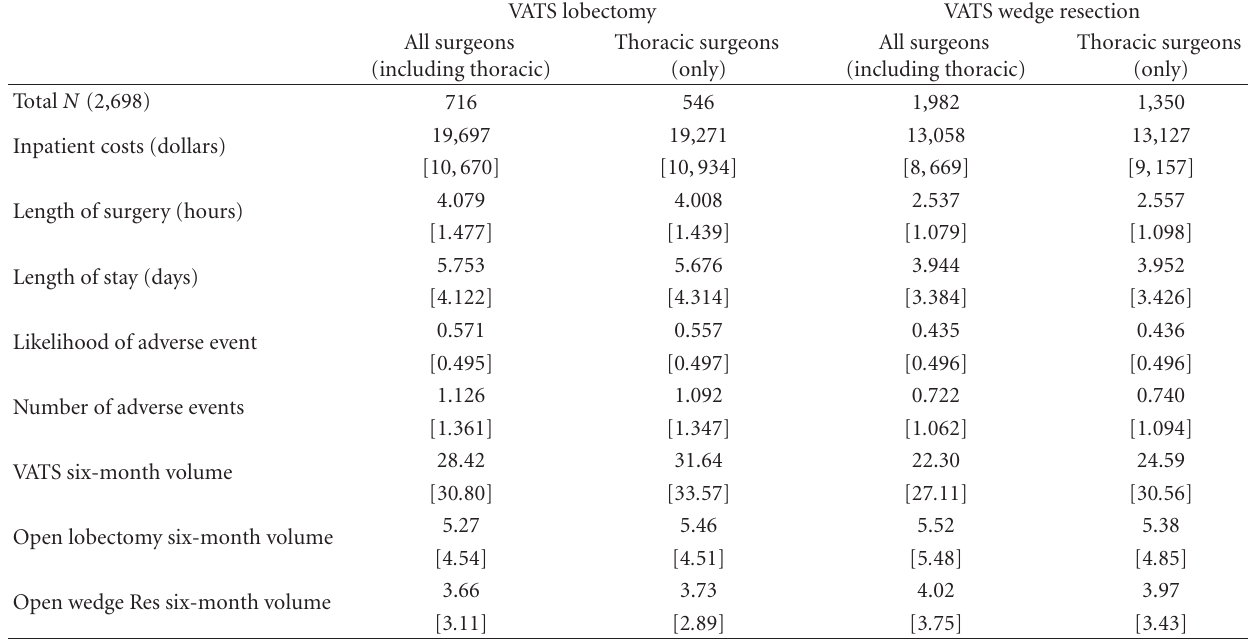
Table 4: Volume and outcomes measures ∗ .